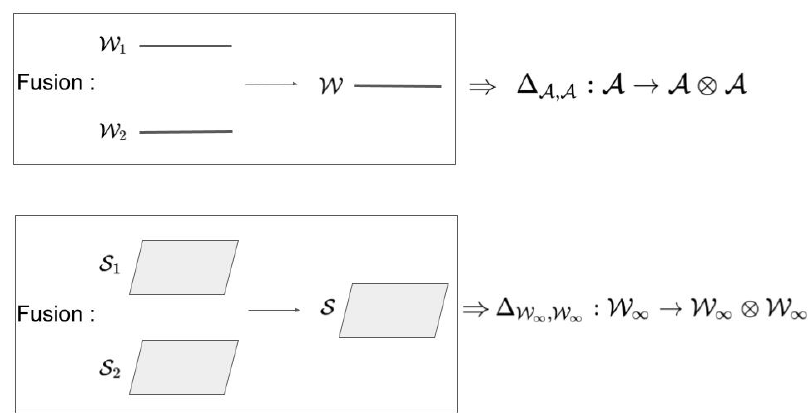
Figure 1: The top figure schematically describes that the Wilson line fusion induces the coproduct in A . The bottom figure shows the surface operator fusion induces the coproduct in W ∞